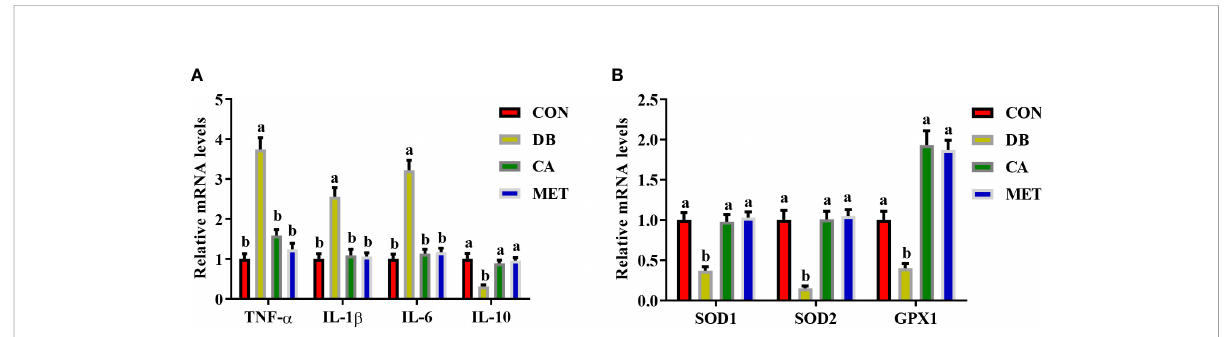
FIGURE 4 Effects of chlorogenic acid on the expression of genes encoding in fl ammatory cytokines and antioxidant enzymes in the livers of diabetic db/db mice. (A) Expression of genes encoding in fl ammatory cytokines; (B) Expression of genes encoding antioxidant enzymes. Data are expressed as the means ± SEMs, n=6. a,b Groups that share the same superscript letters are not signi fi cantly different from each other ( P <